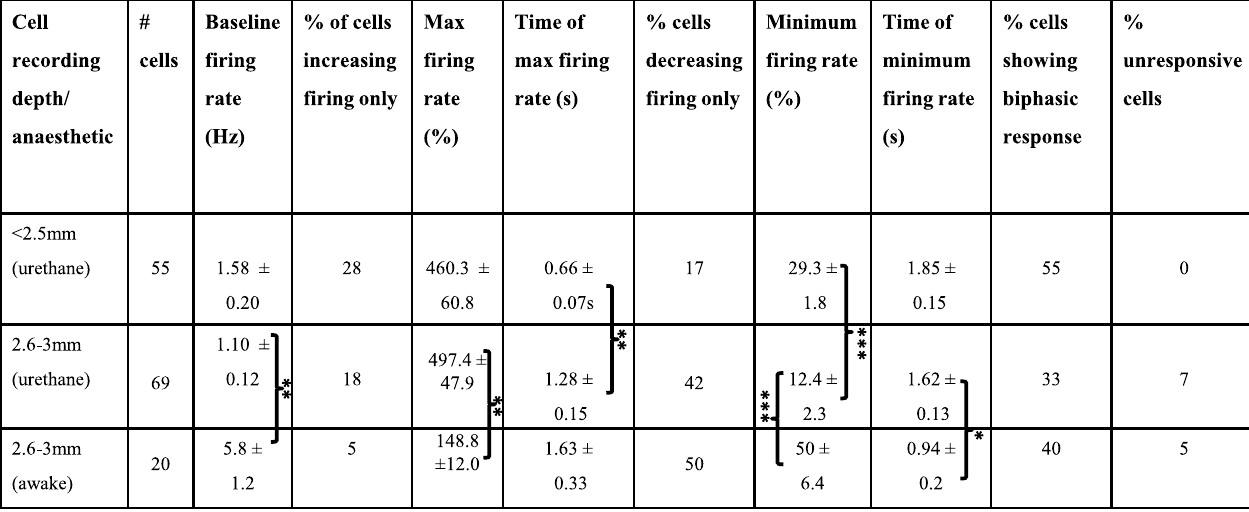
Table 1 | Frontal cortex cell responses following FN